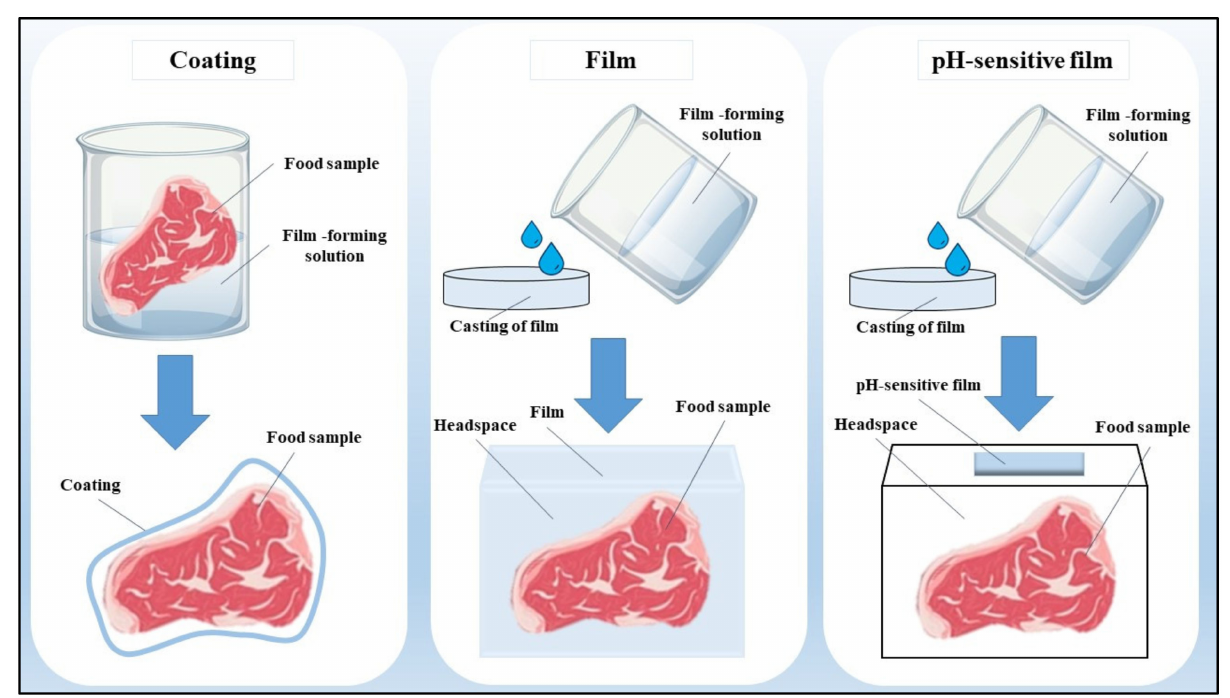
Figure 1. Applications of active packaging as coatings, film, and pH-sensitive